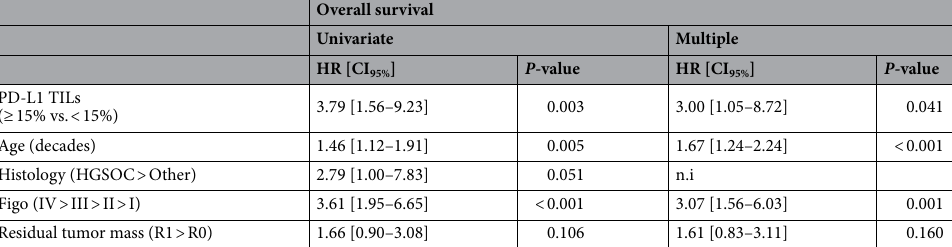
Table 6. Univariate and multiple Cox regression overall survival analyses of PD-L1 of TILs percentages in peritoneal metastases. Combined hazard ratios and p-values for the dichotomized PD-L1 expression in TILs in univariate Cox-regressions (left) or multiple Cox-regressions, corrected for age, FIGO stage, and residual tumor mass (right). HR, Hazard Ratio; CI 95% , 95% Confidence Interval; OS, overall survival; n.i. = not included; according selection by the backward selection method minimizing the Akaike Information Criterion